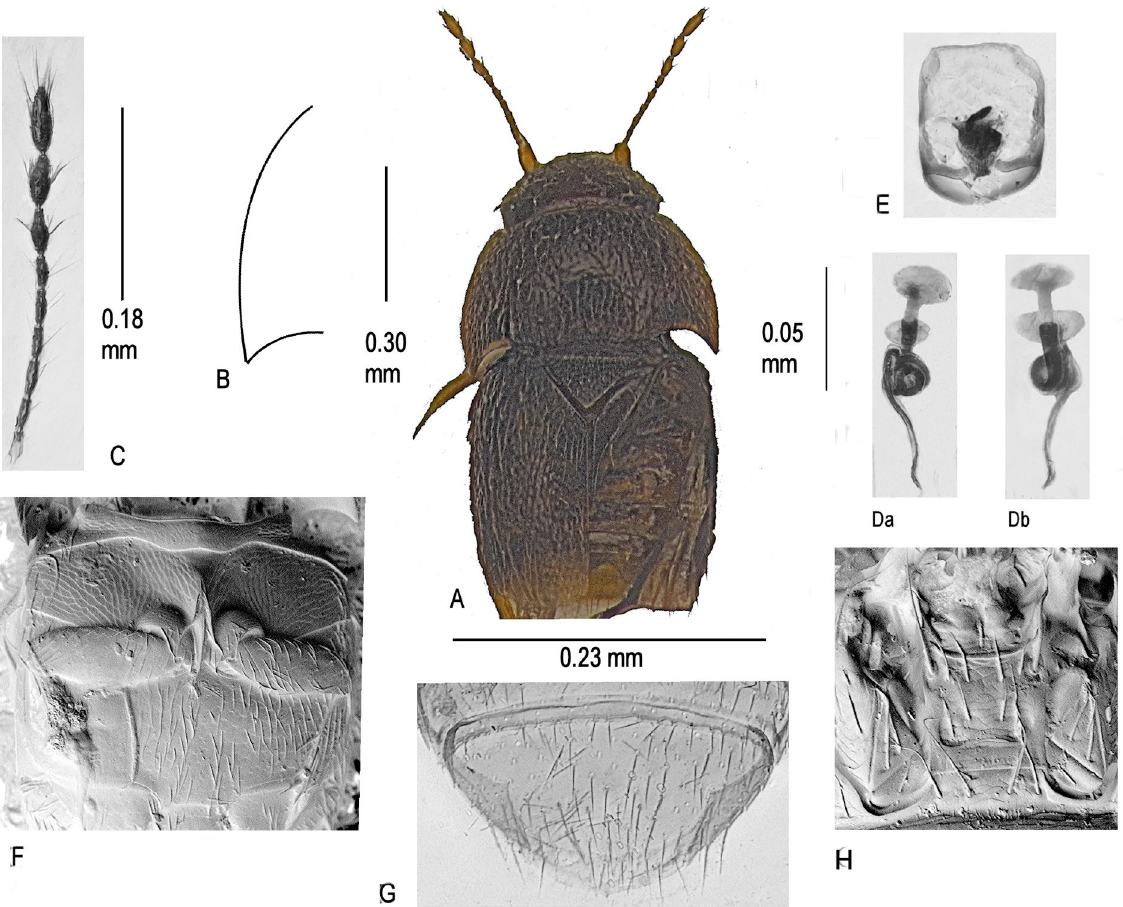
Fig. 14. Acrotrichis acuta sp. nov. A . Habitus. B . Hind angle of pronotum viewed at 45°. C . Antennomeres III–XI. Da–Db . Spermatheca. E . Aedeagus. F . Meso- and metaventra ×325. G . Pygidium. H . Mentum and submentum